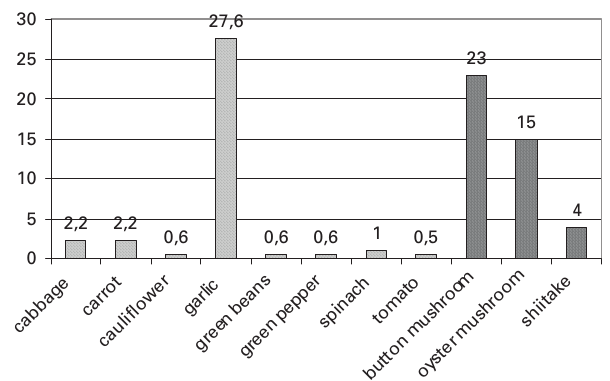
Figure 5. Average selenium content (mg) in 100 g vegetables and mushrooms (fresh)